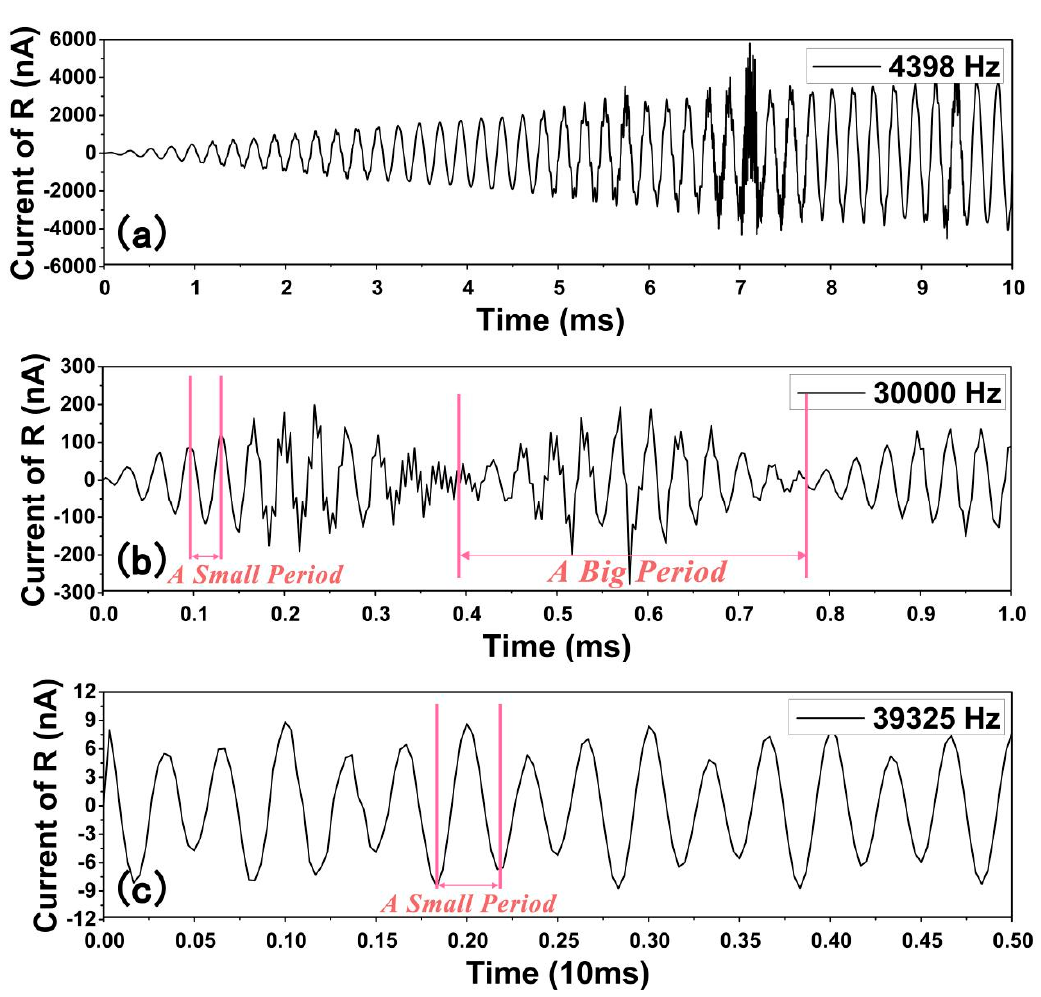
Figure 9. ( a ) ‘Tip shape’ relationship. Current response of the cylinder modified structure under 4398 Hz. ( b ) ‘Fusiform shape’ relationship. Current response diagram of ‘Big period’ and peak value of 30,000 Hz with cylinder modified-structure. ( c ) Current response diagram of pristine structure at 39,325 Hz. (Complete diagrams are all listed in the support information) (The x-axis of the three diagrams are all ‘time(s)’). (Current of R shows the current of the resistance).